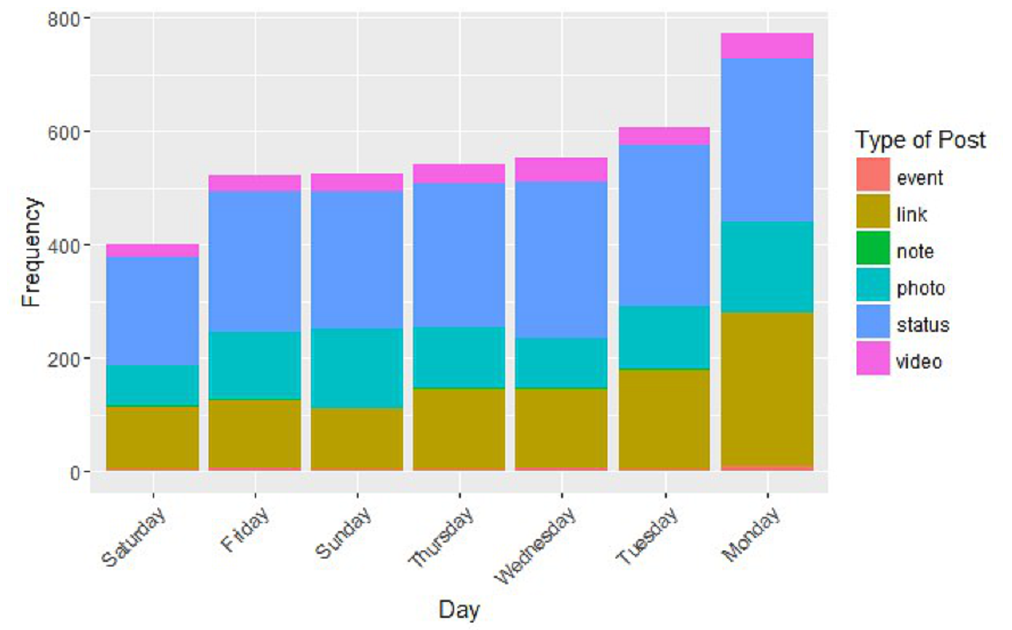
Figure 5. Day frequency vs. type of